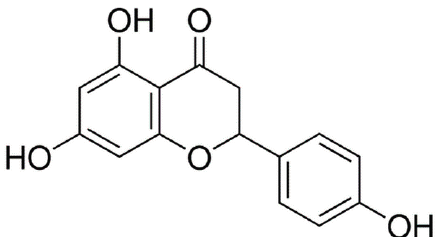
Figure 1. Chemical structure of naringenin (NAR) with a molecular formula of C 15 H 12 O 5 and a molecular weight of 272.25